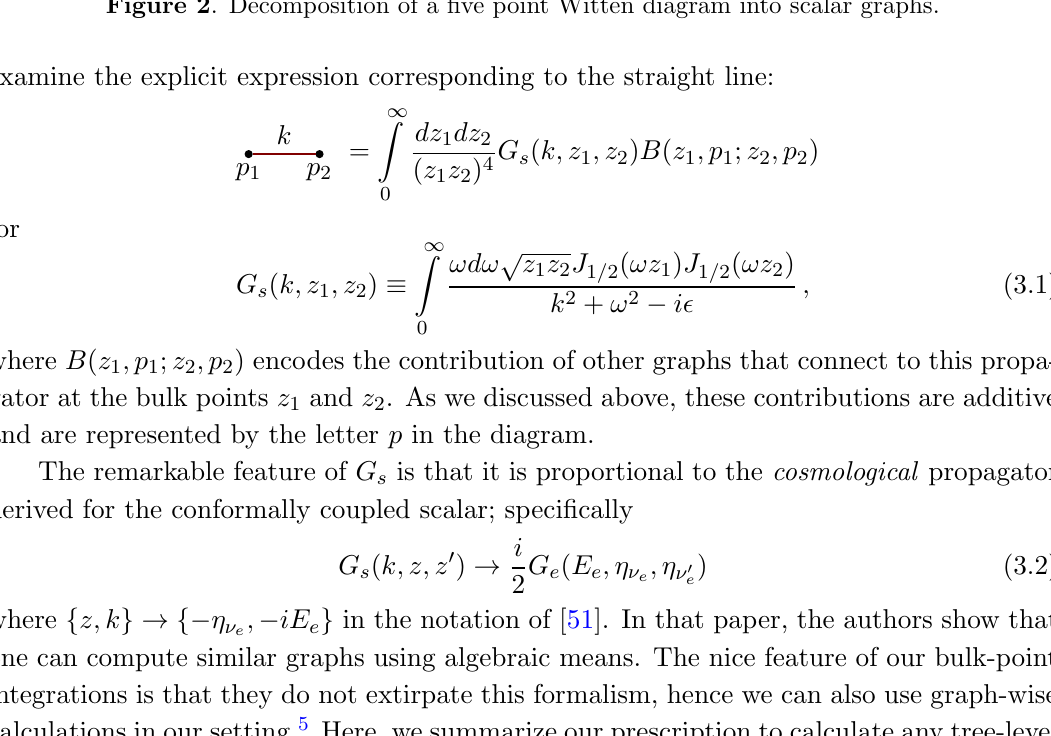
Figure 2 . Decomposition of a (cid:12)ve point Witten diagram into scalar